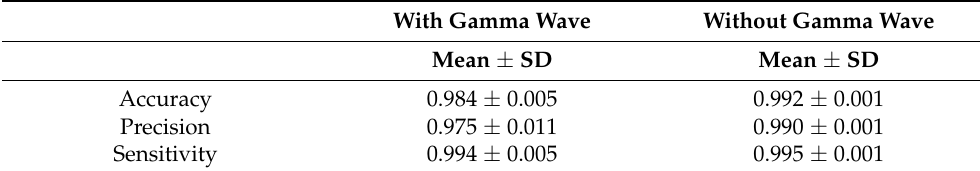
Table 1. Results of 50 iterations of 10-fold cross-validation. Inference performance by the linear discriminant analysis random forest (LDARF) classifier with test data subsets (closed eye rest dur- ing mouth and nose breathing) in each cross-validation is presented using accuracy, precision, and sensitivity. With Gamma Wave